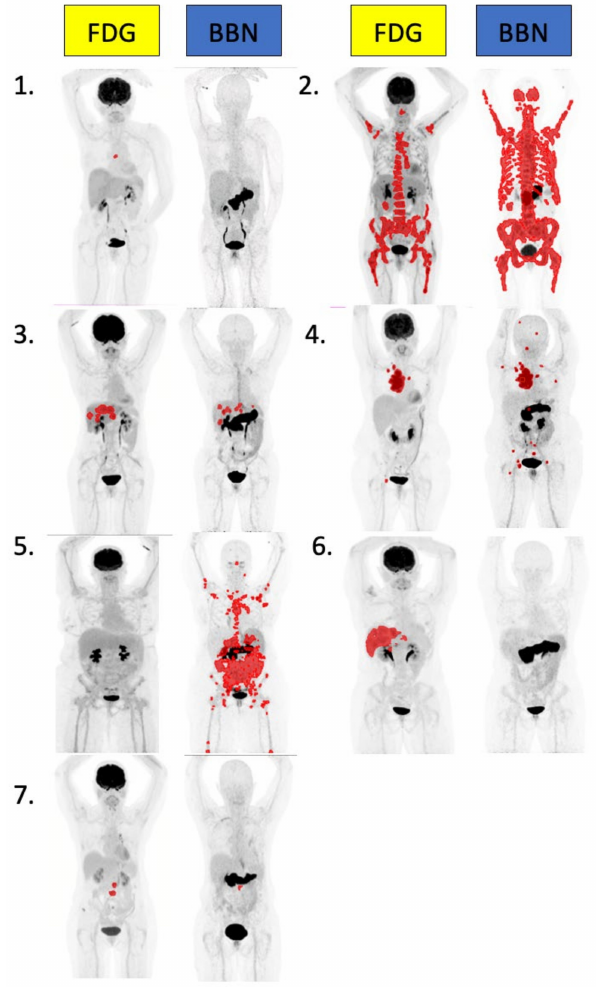
Figure 1. Representative MIPs of total tumor volume quantitation from all 7 patients using MIM soft-